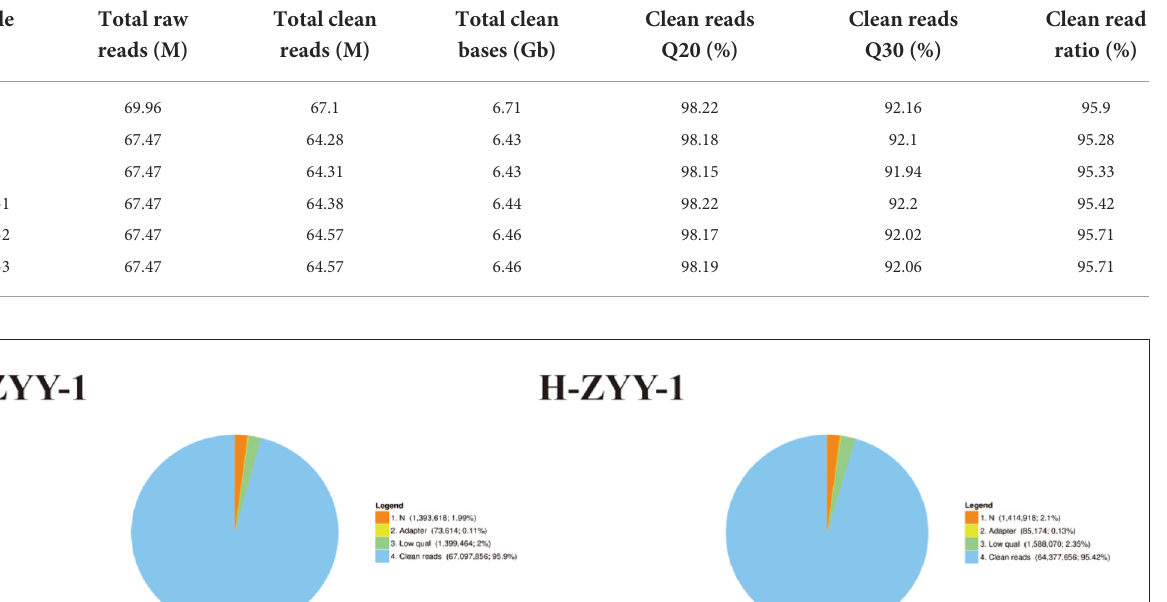
TABLE 2 Filtered read quality statistics.